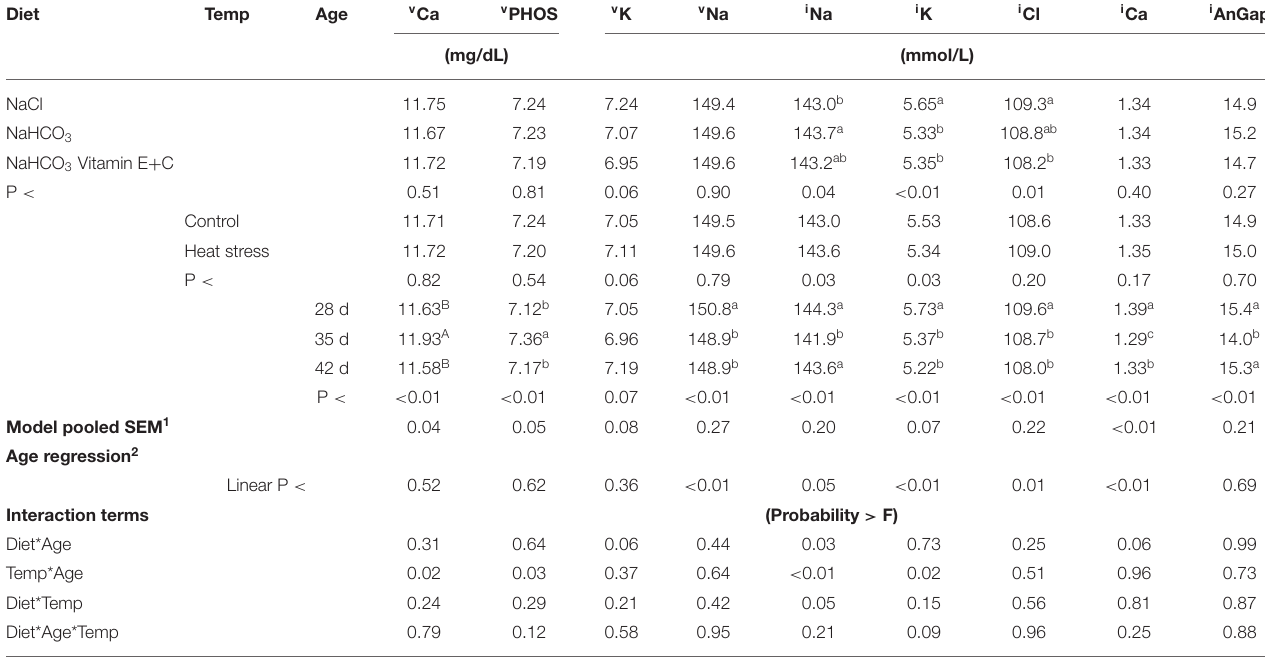
TABLE 3 | Effect of diet, temperature (Temp), and Age on broiler blood mineral composition. Diet